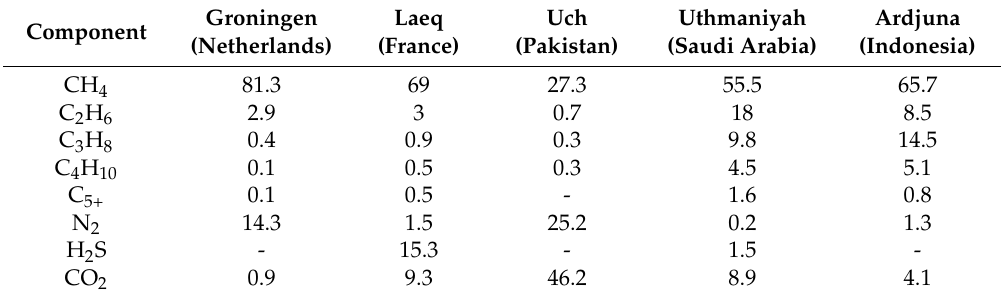
Table 2. Composition of natural gas reservoirs (volume percent) in some regions of the world [9]. Groningen Component